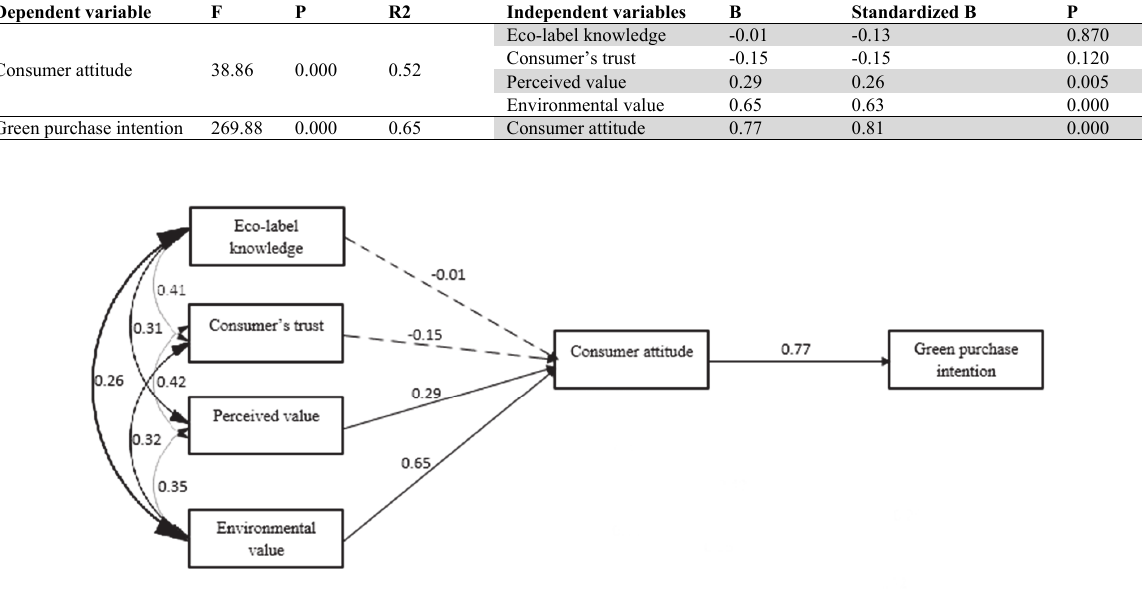
Fig. 3. Model summary